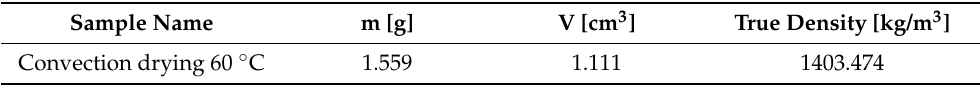
Table 9. True density of apple pomace dried by convection at 60 ◦